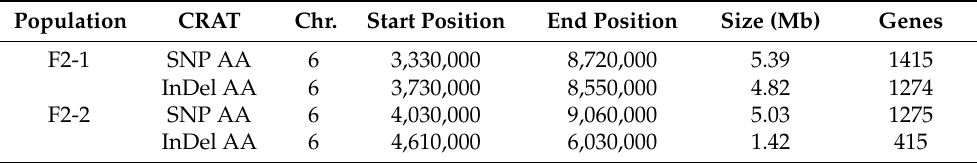
Table 4. Statistics information of candidate association region in BSA-seq.